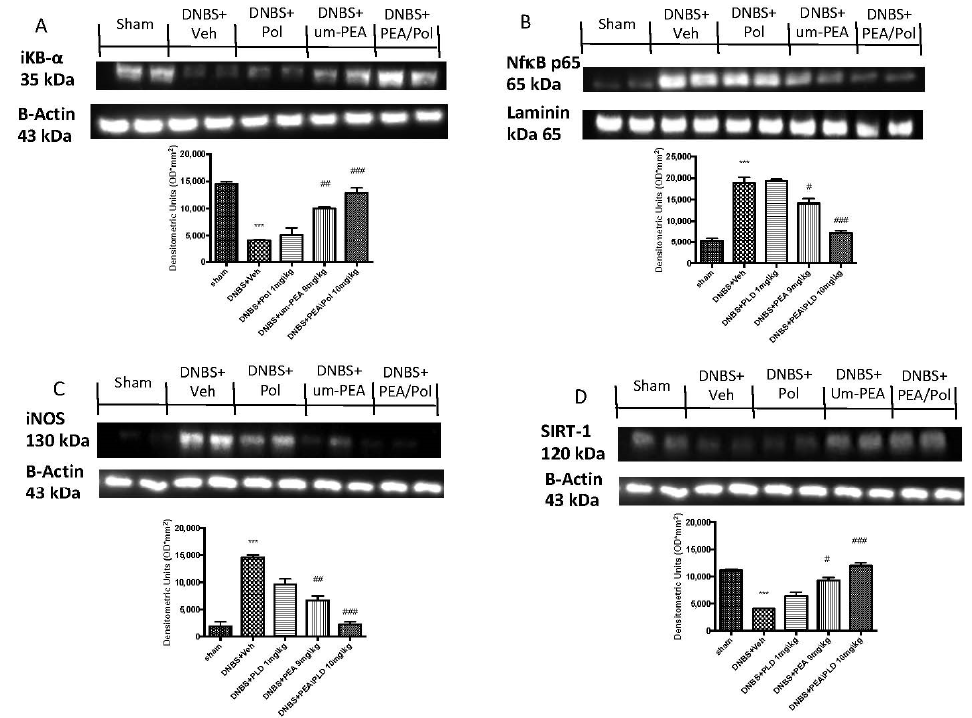
Figure 6. Western blots for NF-kB, IKB- α , iNOS, and SIRT-1. Representative Western blots for cytoplasmic IKB- α degradation ( A ), nuclear NF- κ B translocation ( B ), cytoplasmic iNOS ( C ), and cytoplasmic SIRT-1 expression ( D ) were performed. A demonstrative blot of lysates (six animals/group), with a densitometric analysis for all animals, is shown. The results in ( A – D ) = means ± SEM of six animals in each group. *** p < 0.01 vs. sham, # p < 0.05 vs. DNBS., ## p < 0.01 vs. DNBS, ### p < 0.001 vs. DNBS.